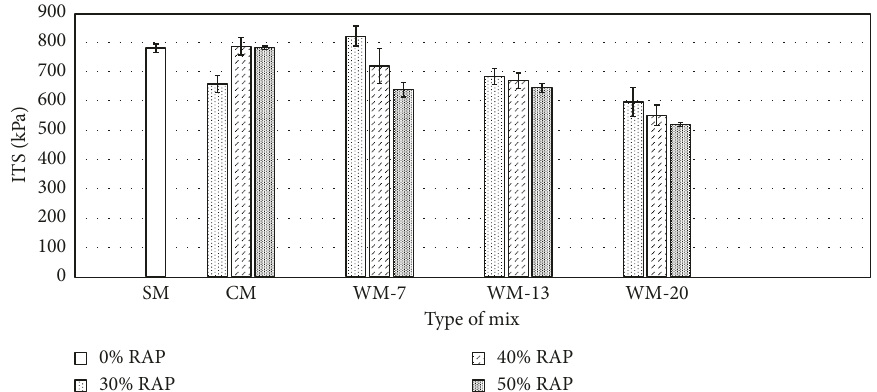
Figure 3: Comparison of ITS for mixes with no RAP and rejuvenated by CR with mixes rejuvenated by WEO.